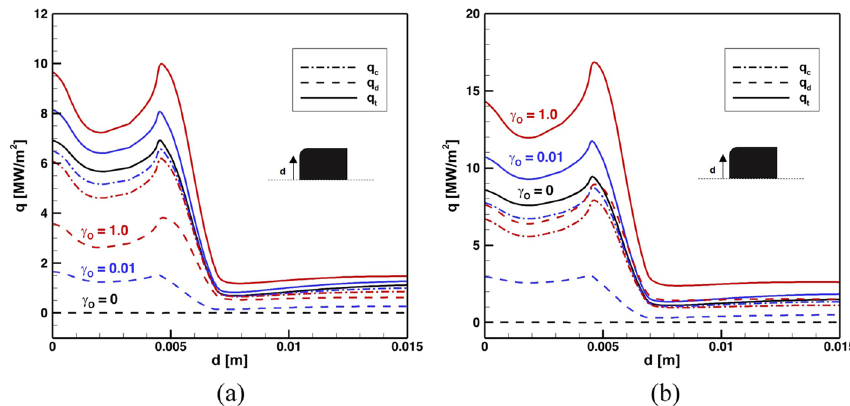
Fig. 14 Heat flux on a calorimeter probe for the mixtures: ( a ) O 2 -Ar and ( b ) N 2 -Ar [132]